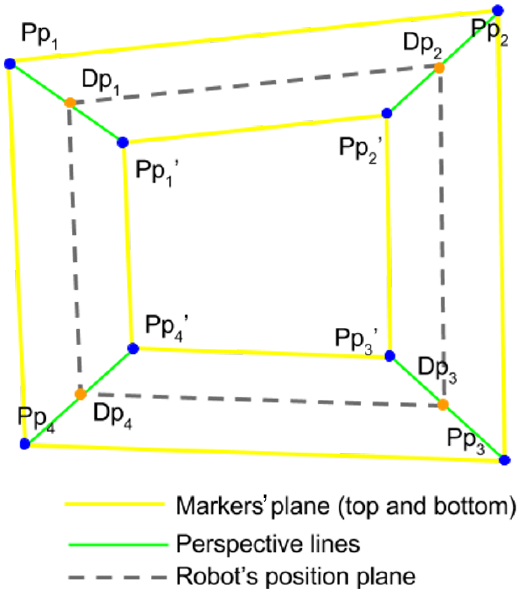
Figure 8. Diagram representing an image captured by the camera in which the top plane formed by the points Pp n and the bottom plane formed by Pp (cid:48) n points is highlighted in yellow. The shown in green. Intersecting points of the robot’s submerged plane (grey dashed lines) are marked in